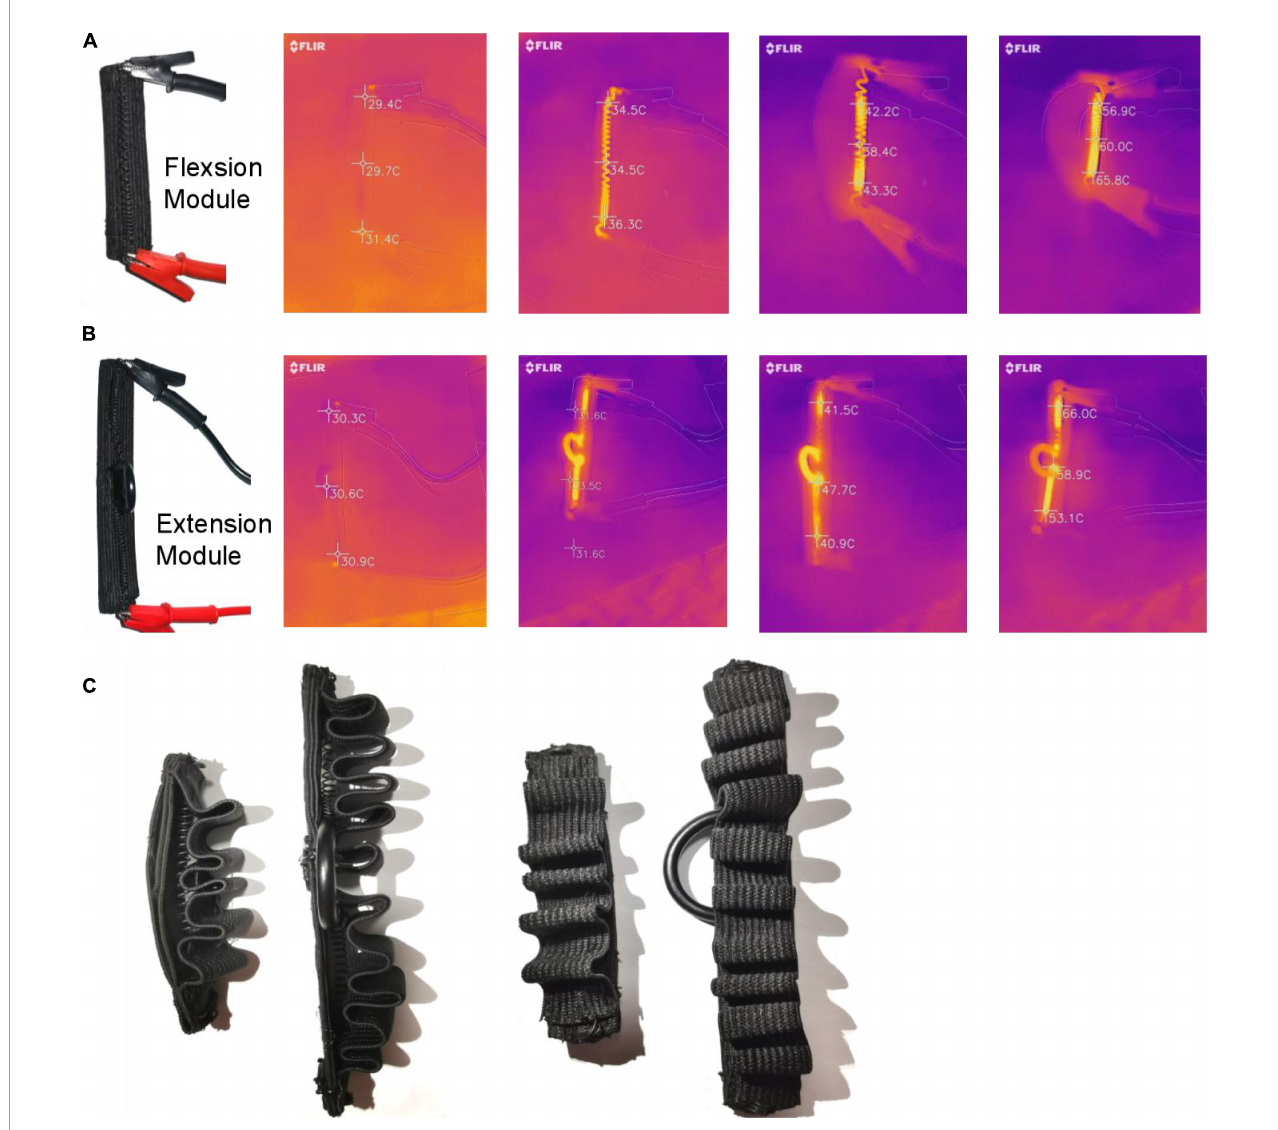
FIGURE10 Temperature test and insulation of SSCS. (A) Flexion module, (B) extension module, (C)